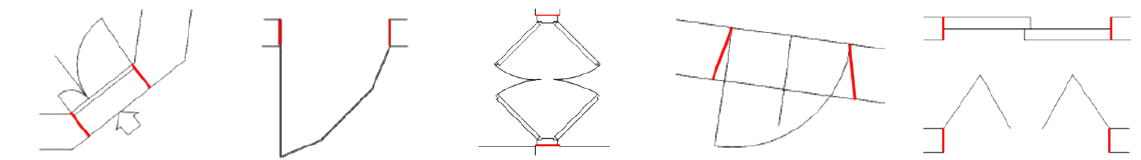
Figure 7. Selection of different door openings that can be detected with the automated approach.